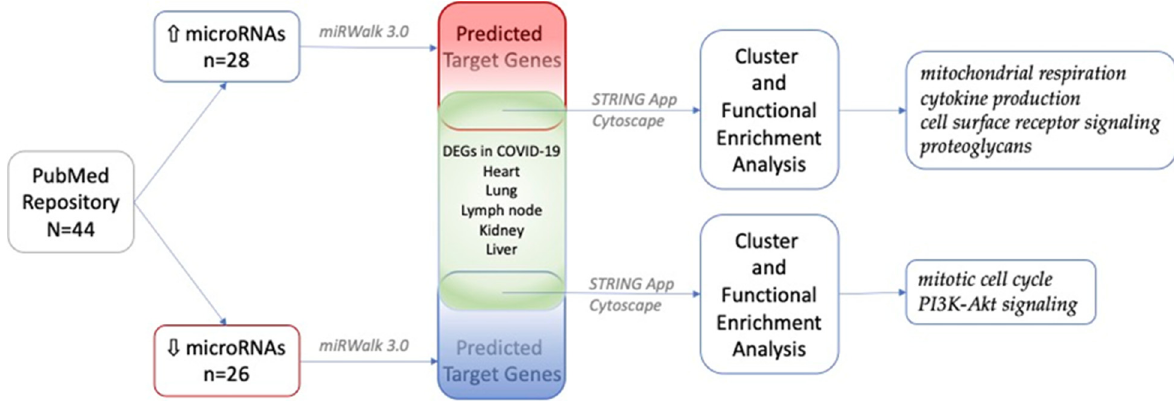
Figure 1. The analytical pipeline used in the current study. N—number of research papers included in the analysis; n—number of microRNAs; arrow up—upregulated microRNAs; arrow down— downregulated microRNAs. Table 1. List of miRNAs in silico predicted and experimentally validated. Downregulated